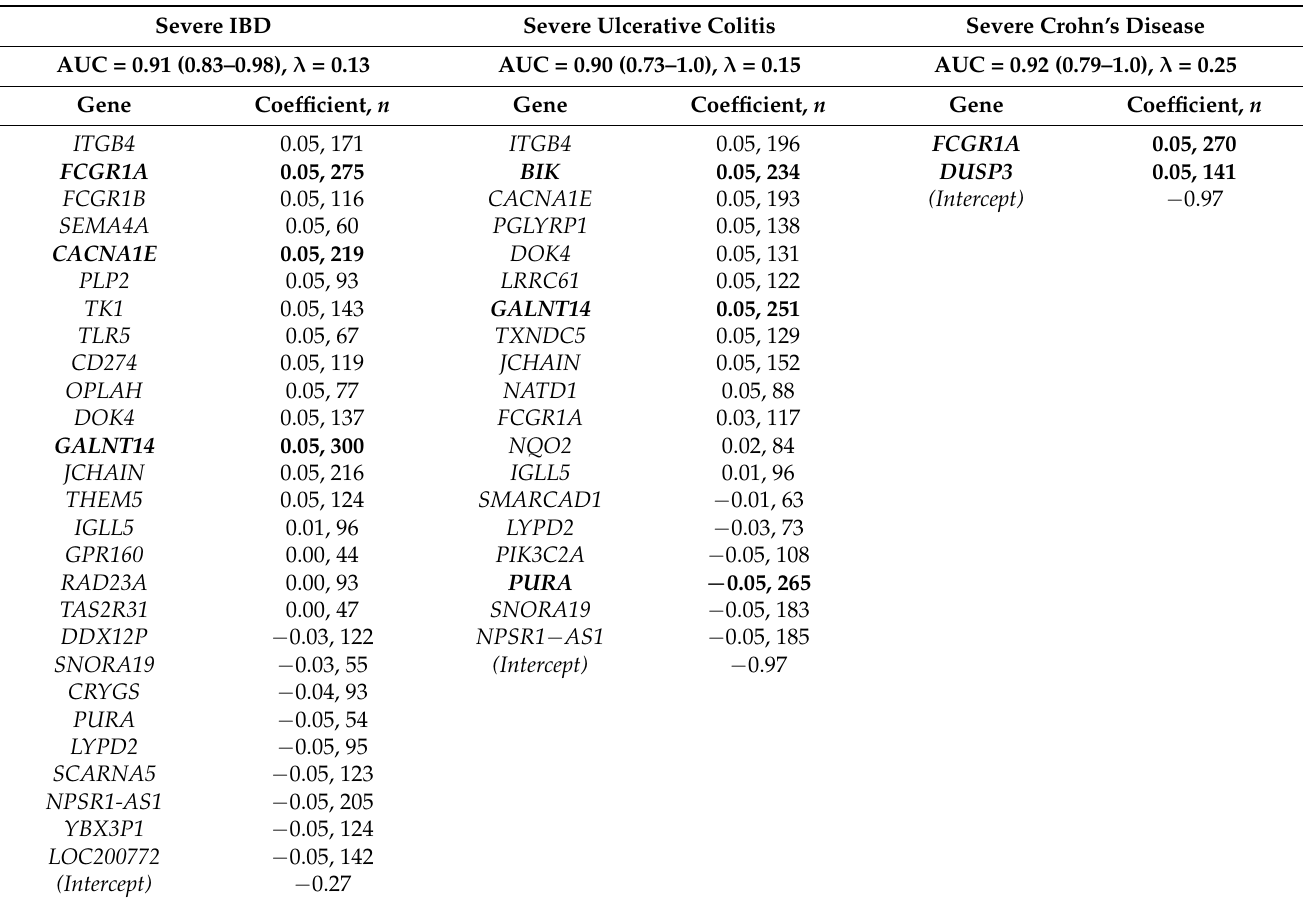
Table 2. Genes were selected by lasso regression to best discriminate patients with severe IBD from controls. Coefficients are presented together with the number of times the given transcript appeared in the tested models across the cross-validation/lambda grid (greater values indicate transcripts more systematically linked to IBD). The top three genes (highest n ) are indicated in bold. The area under the curve (AUC, 90% confidence interval), lambda shrinkage parameter, and the intercept for each model are also presented. Please note that genes with the most discriminatory power are present at the top and the bottom of the